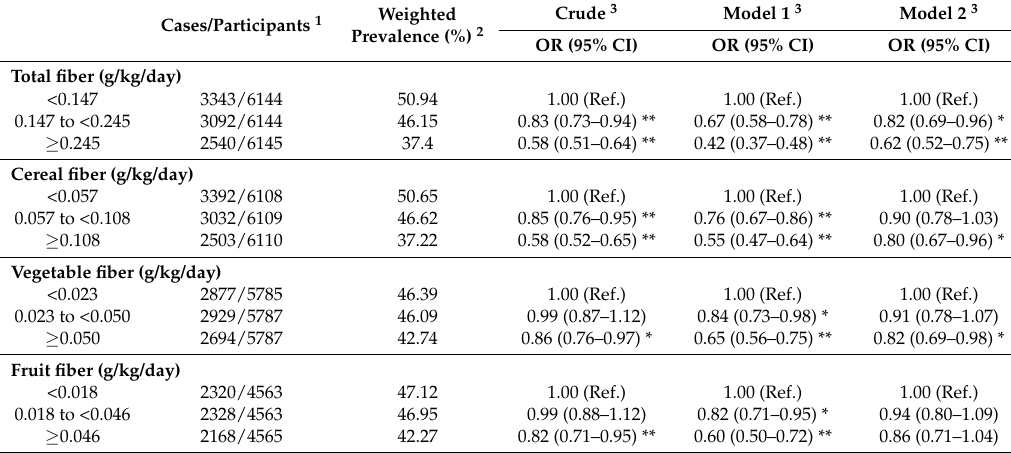
Table 2. Weighted ORs and 95% CIs for hypertension according to tertiles of dietary fiber intake, NHANES 2007–2014, adults aged ≥ 18